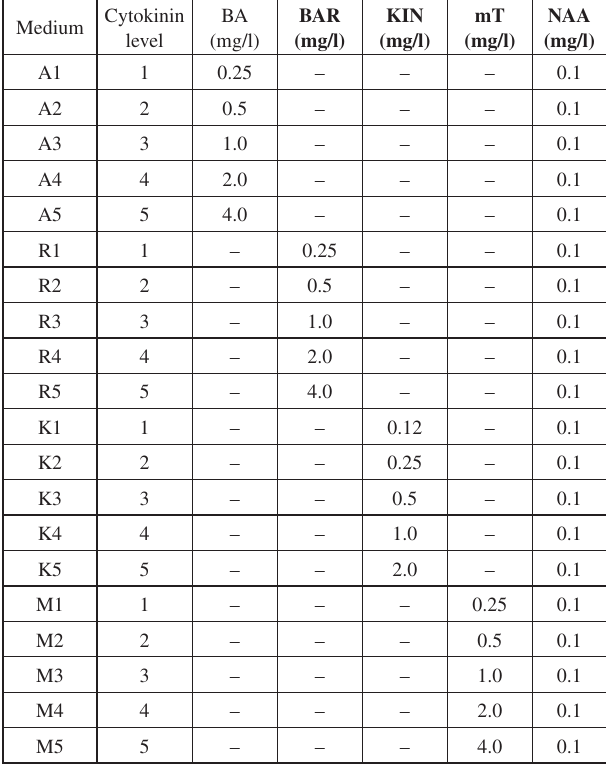
Table 1. Growth regulators of MKC ( Knudson, 1946) medium used during in vitro multiplication of Nidularium ‘Kertész Jubileum’